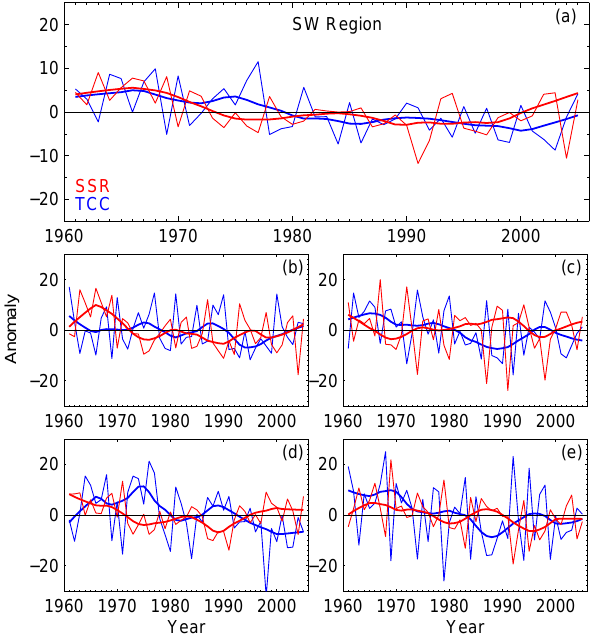
Fig. 5. The same as in Fig. 2, but in Southwest